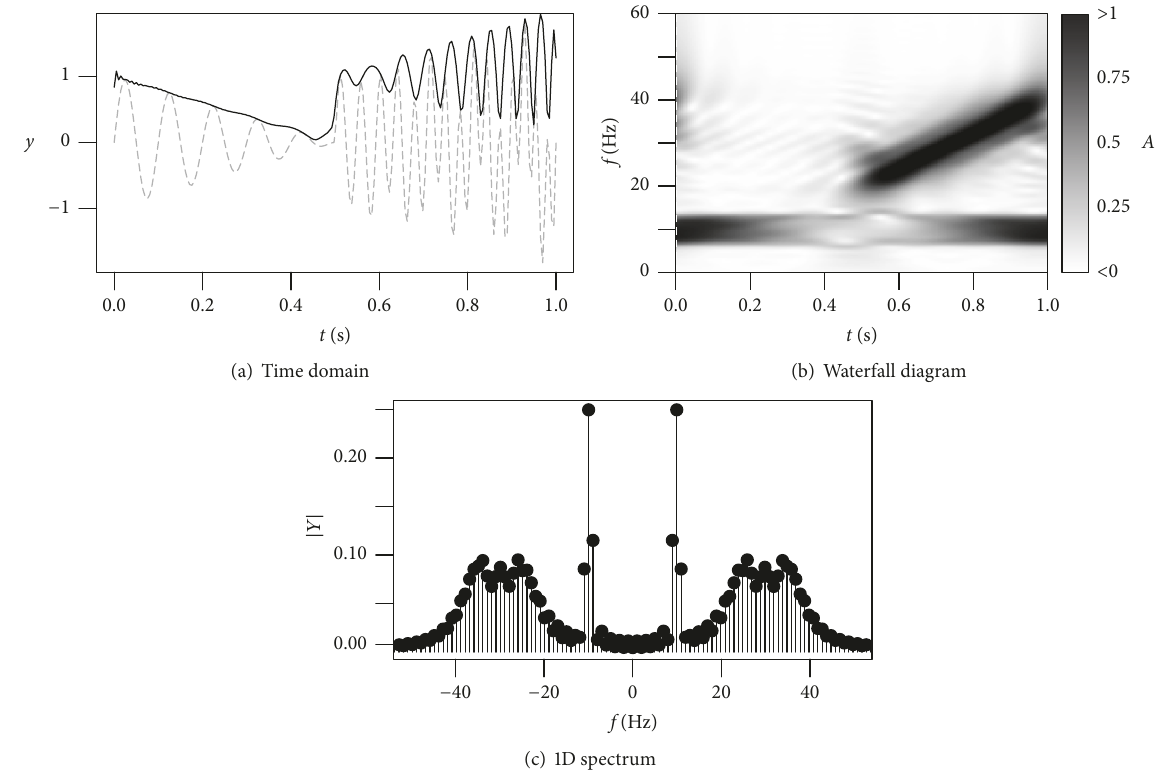
Figure 14: Complex example for the temporal-dependent spectral decomposition. (a) shows the time series and (b) its decomposition. Panel (c)demonstratesthatthesimple1Dspectrumwouldproducemisleadingresults.Hereonecanonlyidentifythe10 Hzcarrier,butthefrequency drift is hidden behind the wide band spectrum at around 30